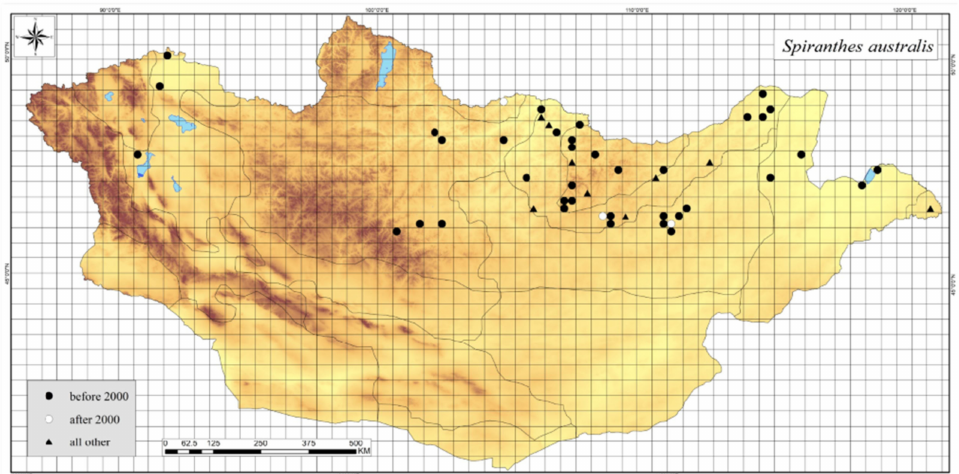
Figure A26. Distribution map of Spiranthes australis in